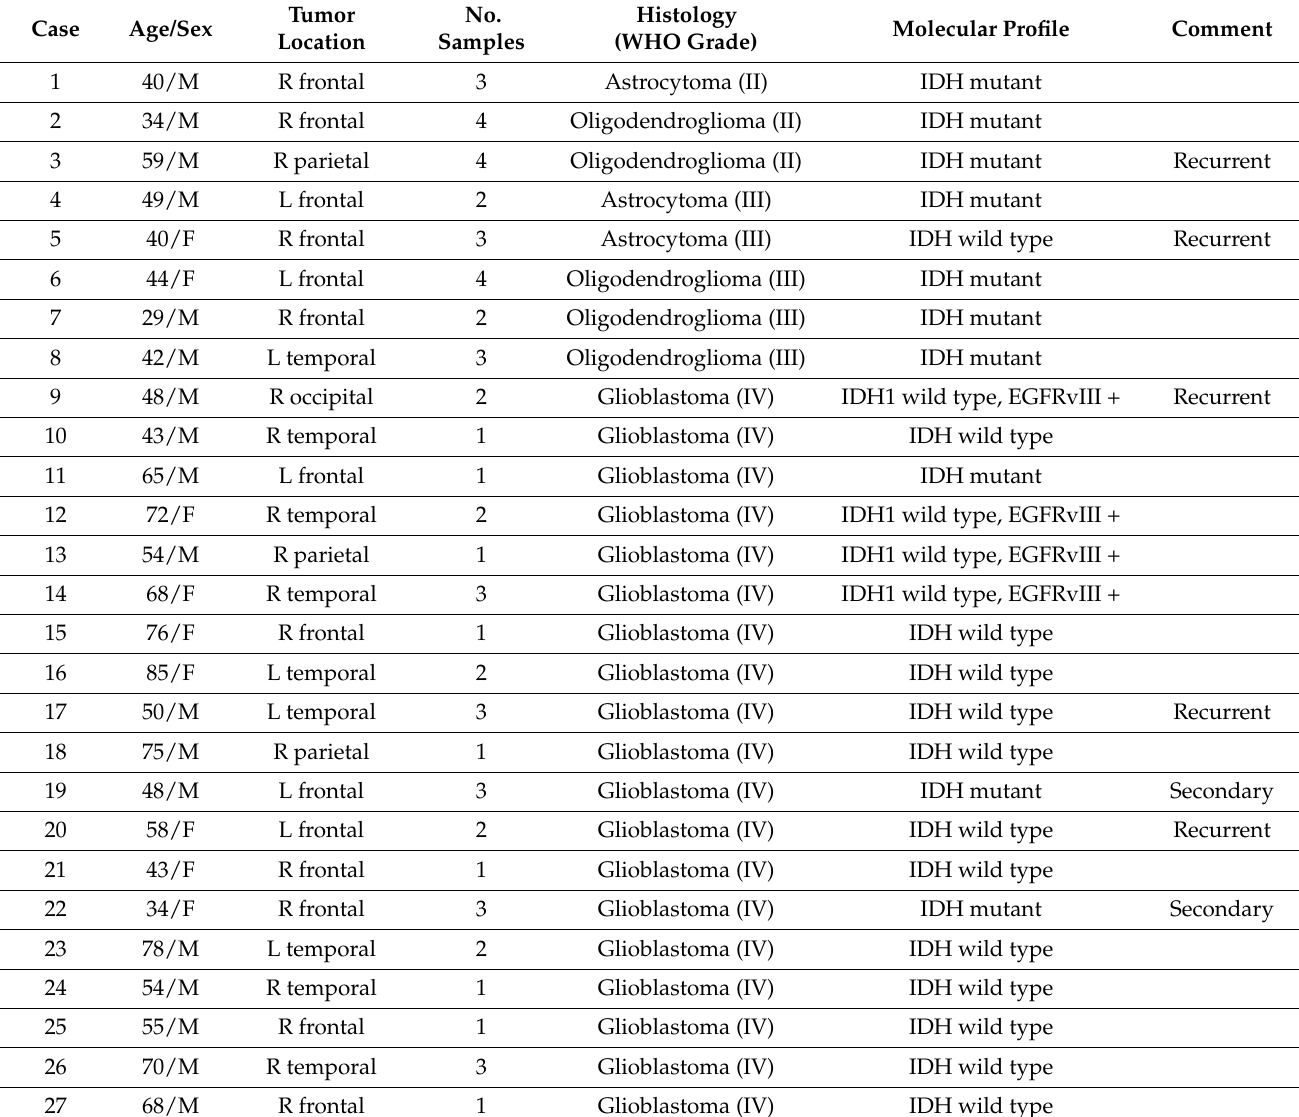
Table 1. General features of tumor